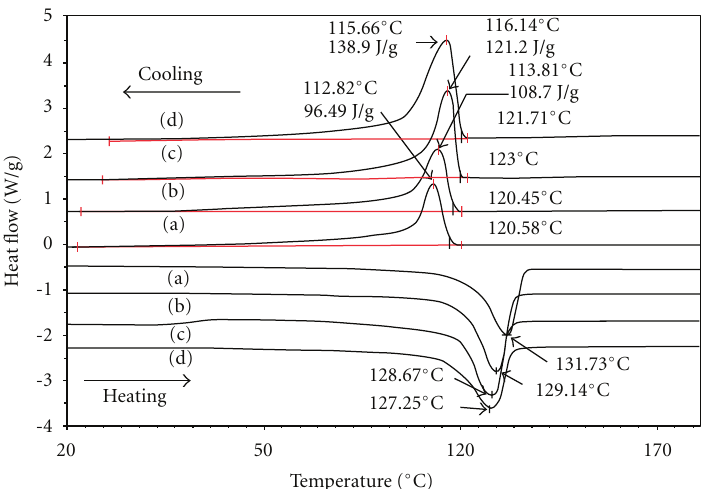
Figure 5: DSC heating and cooling curves of (a) Neat UHMWPE (b) Strain hardened UHMWPE (c) UHMWPE-MWCNT (d) Strain hardened UHMWPE-MWCNT.